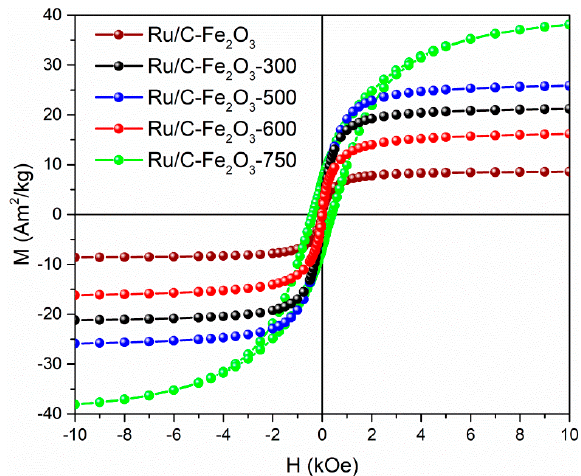
Figure 4. Room-temperature magnetisation curves for the catalysts Ru/C-Fe 2 O 3 , Ru/C-Fe 2 O 3 -300, Ru/C-Fe 2 O 3 -500, Ru/C-Fe 2 O 3 -600, and Ru/C-Fe 2 O 3 -750.